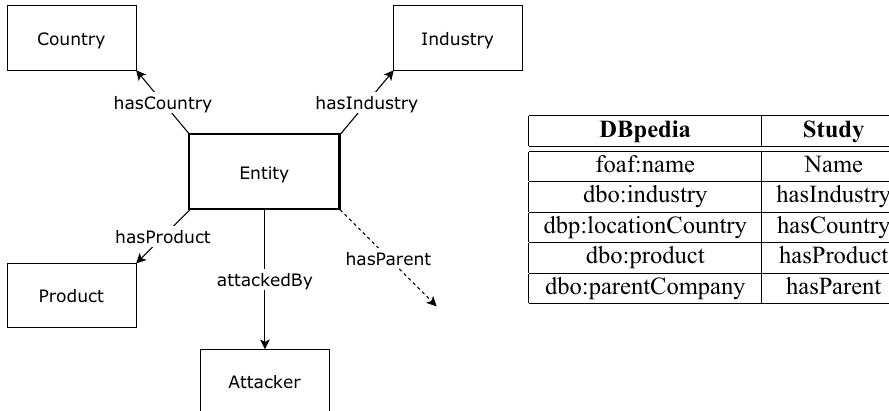
Figure 3. Structure of the novel strategic level cyber ontology. Subjects and objects are entities (boxes) that are connected via their relative predicates (arrows). The labels tell the class names in the ontology. The hasParent relationship is from an entity to another entity. The table lists the similarities between the predicates of the extraneous data from DBpedia and the corresponding predicates ontology in this